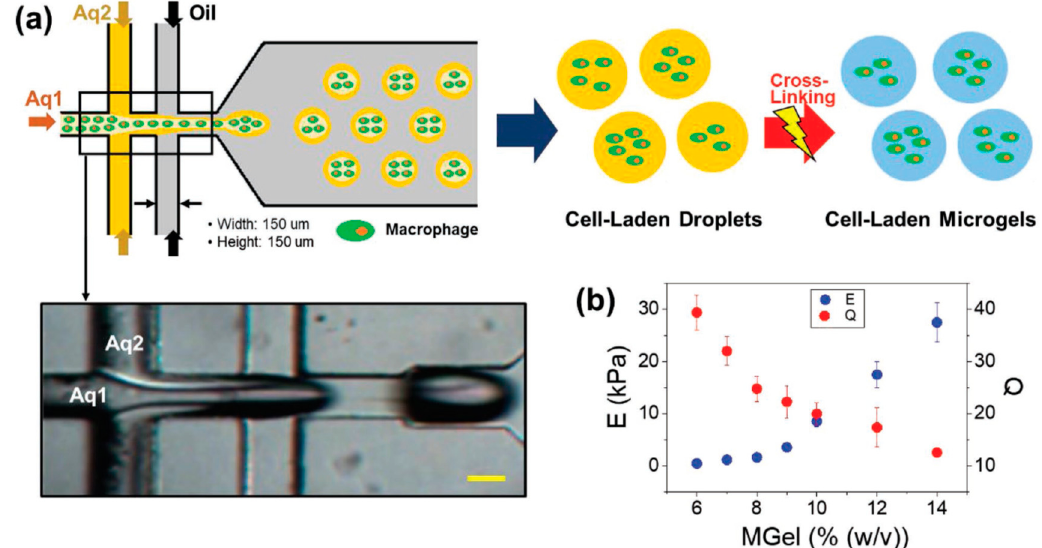
Figure 1. Schematic illustration of a double flow-focusing microfluidic fabrication of macrophage-laden microgels ( a ). The image below shows the delineated core (Aq1) and shell (Aq2) flows during droplet generation (scale bar: 100 µ m). ( b ) Elastic moduli (E) and swelling ratios (Q) of photo-crosslinked MGel hydrogels at various concentrations (mean ± SD, n = 6) [65]. (Reproduced with permission from Wiley.)